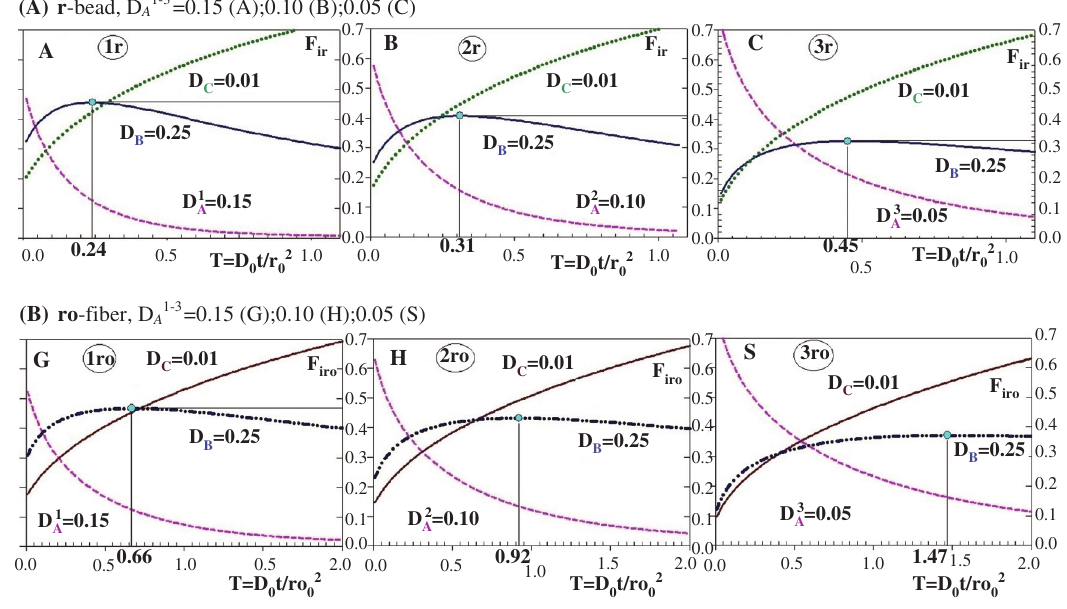
= 0.24 (A), 0.31(B), 0.45 (C); ro -fiber ( b , 2m r